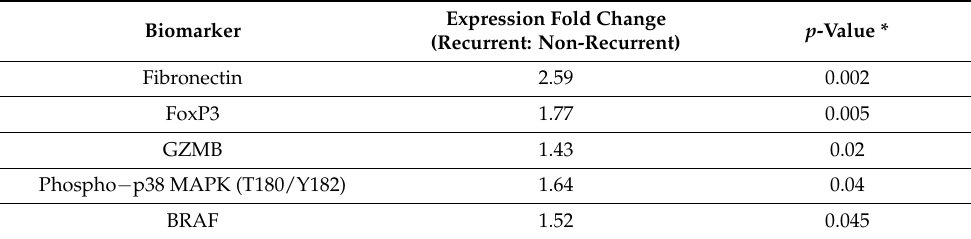
Table 2. Fold-change (log2) differential mean protein expression between recurrent and non-recur- rent patients within tumor compartment.